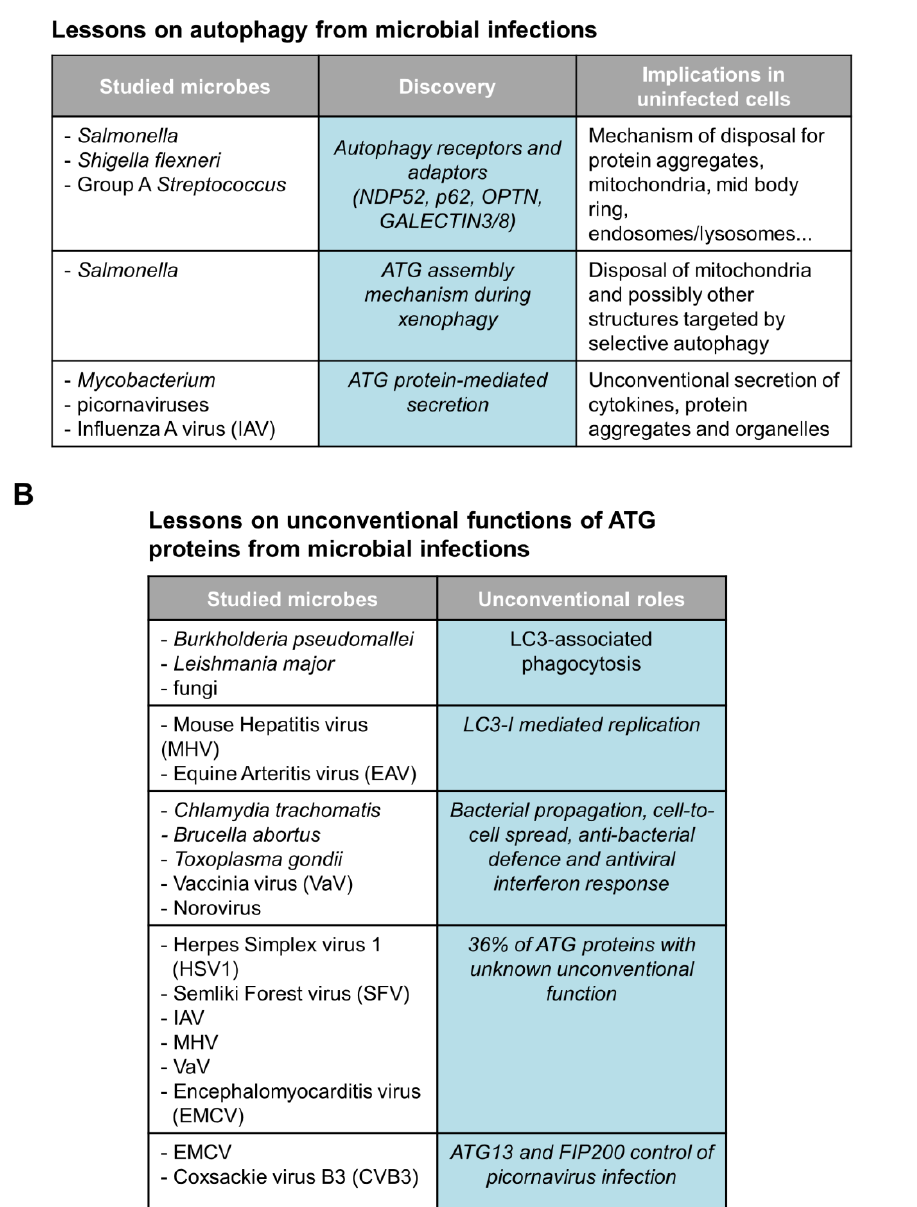
FIGURE 1: Tabular illustration resuming the studies men- tioned in this commentary on microbes that have led to (A) the deciphering of autophagy- related processes and mecha- nisms, and (B) the identifica- tion of unconventional func- tions of the ATG